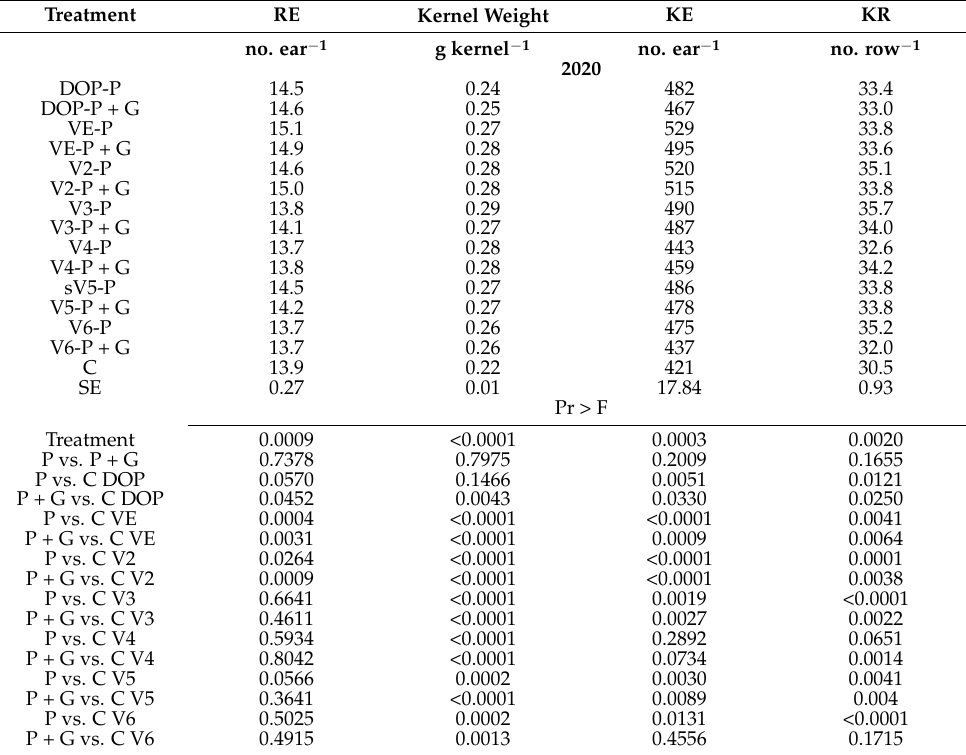
Table A1. Treatment means and significance for maize yield components of rows per ear (RE), kernel weight, kernels per ear (KE), and kernels per row (KR) at Sorenson Research Farm in